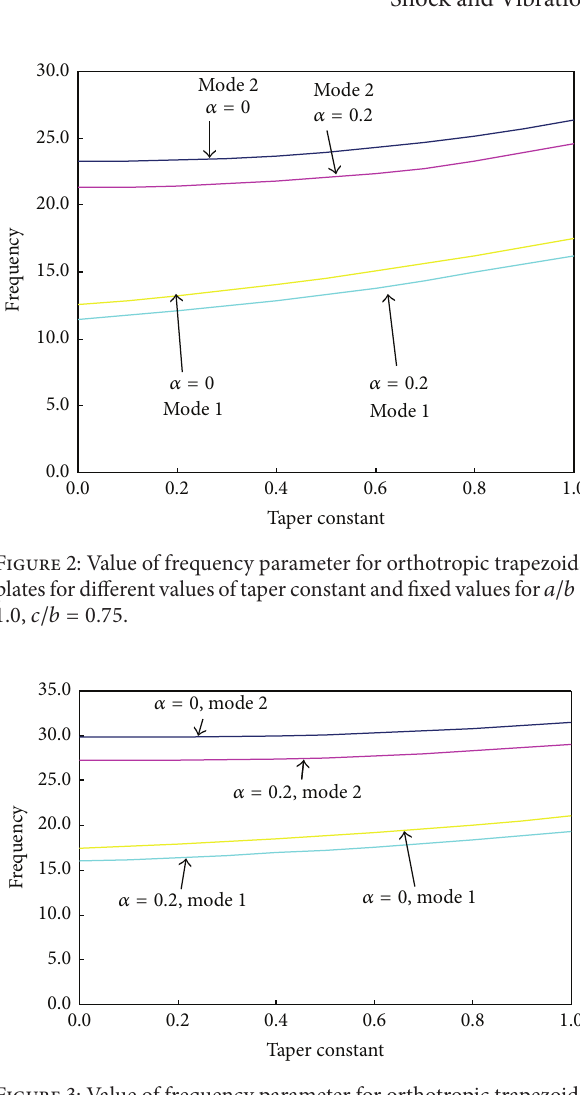
Figure 3: Value of frequency parameter for orthotropic trapezoidal plates for different values of taper constant and fixed values for 𝑎/𝑏 = 1.0 , 𝑐/𝑏 = 0.5